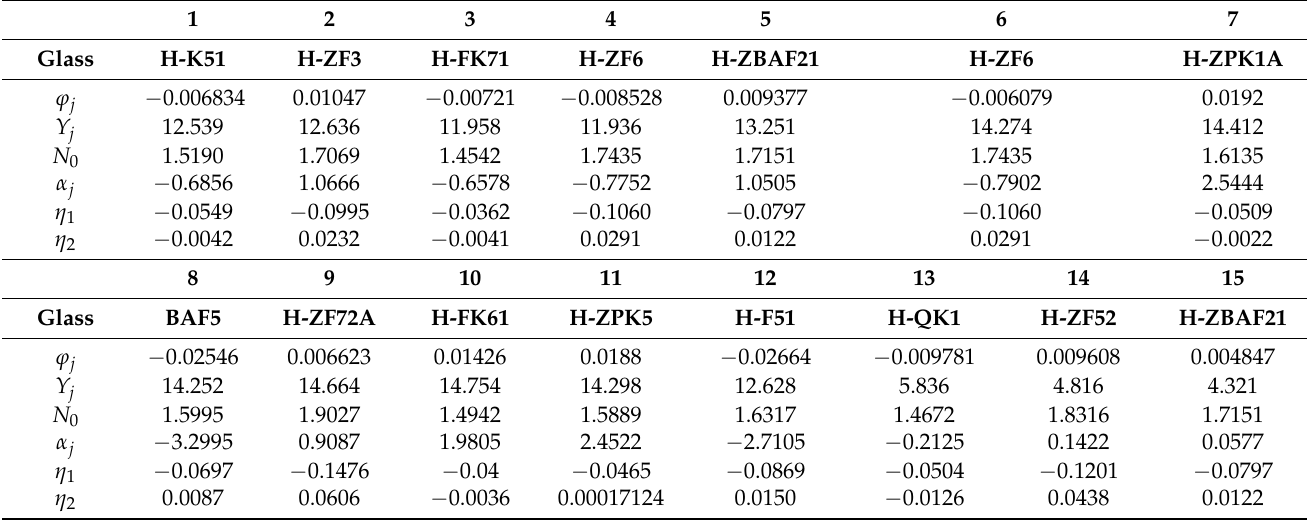
Table 3. Ray-tracing parameters of the initial system.